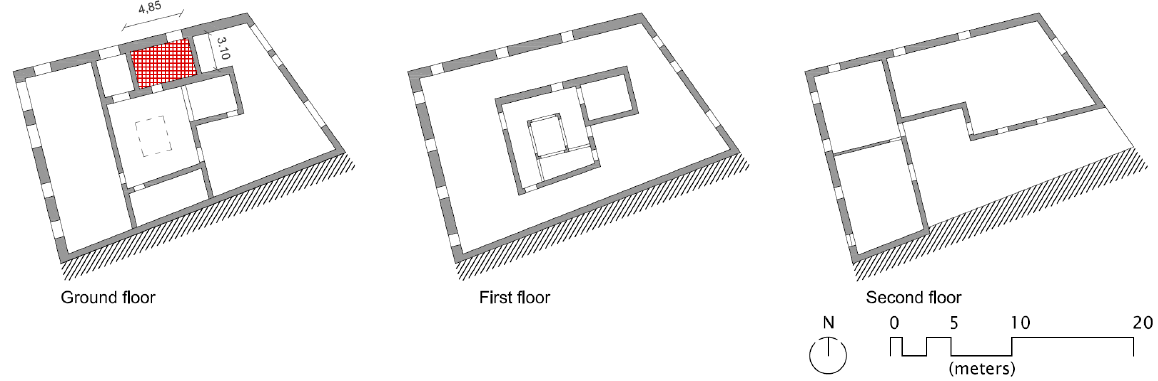
Figure 2. Plan view of the floors of the studied building in Campo de Criptana (Ciudad Real, Spain), indicating the mon- itored room with a red hatching.